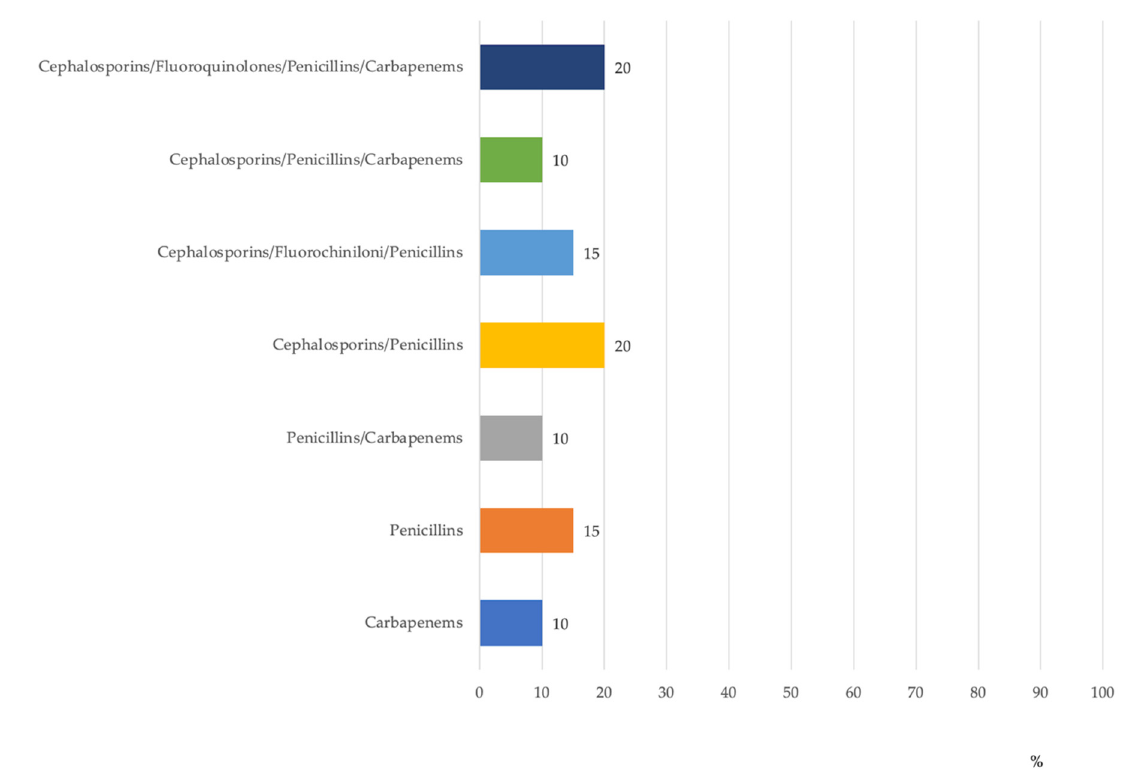
Figure 3. Percentage distribution of antibiotic-resistant P. aeruginosa isolates in dental units by antibiotic groups.